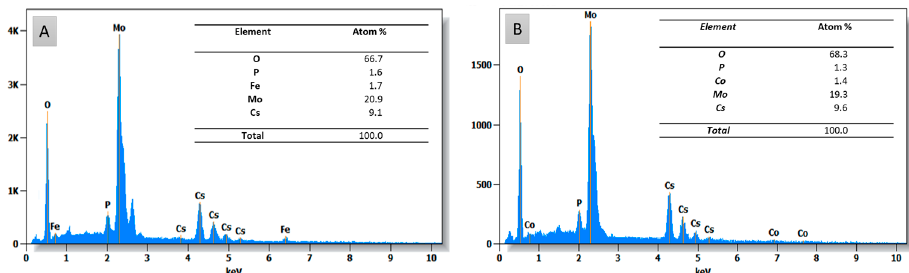
Figure 4. EDX spectra of Cs 5 PMo 11 FeO 39 ( A ) and Cs 5 PMo 11 CoO 39 ( B ).